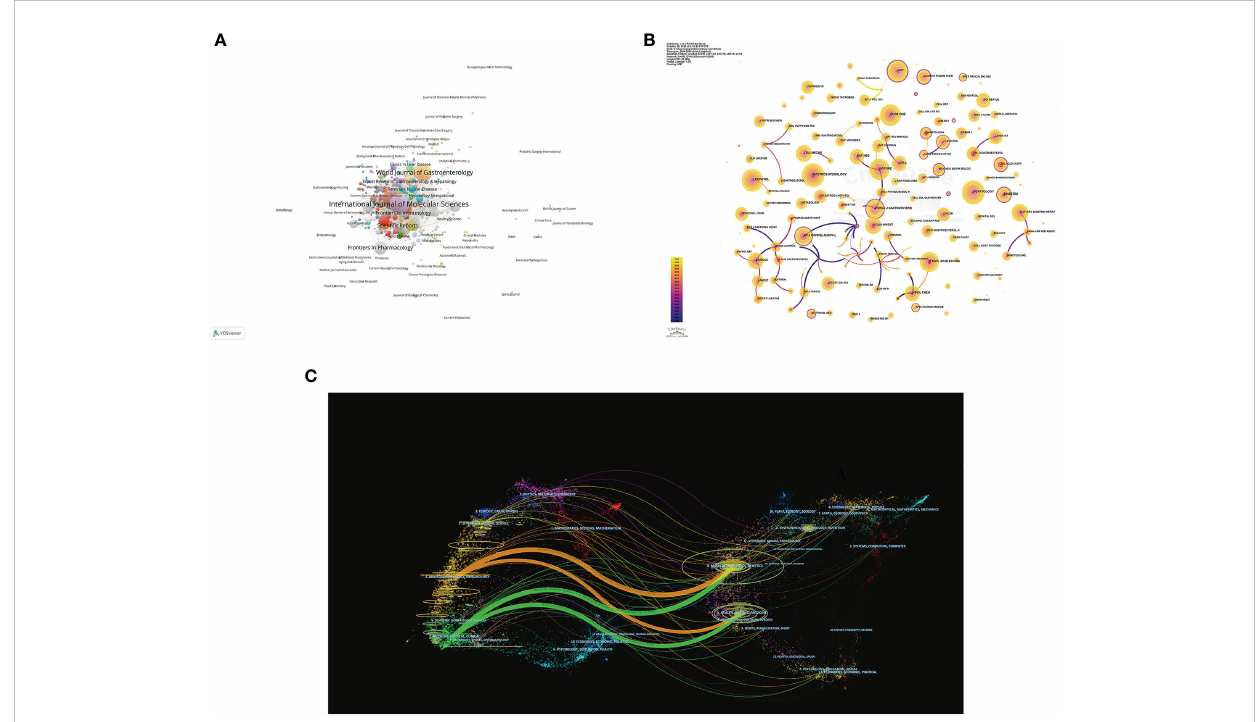
FIGURE 6 Visualization of journals of the gut-liver axis in NAFLD. (A) Network visualization analysis of source journals based on VOSviewer. (B) Visualization of cited journals based on CiteSpace. (C) The dual-map overlay of journals in the gut-liver axis and NAFLD.